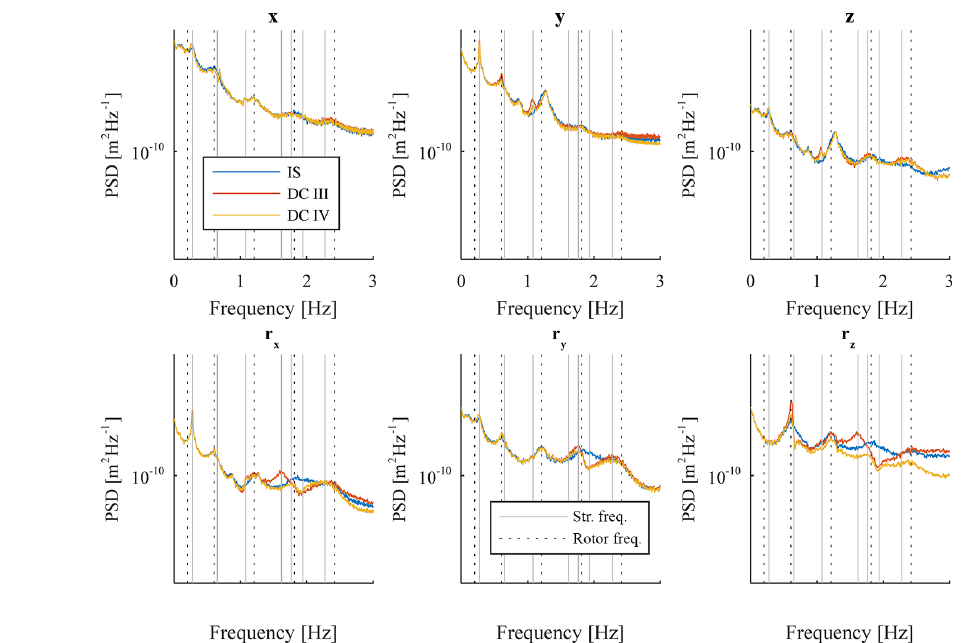
Figure 14. PSD for tower top displacements of DC III and DC IV with a wind speed of 20ms − 1 .